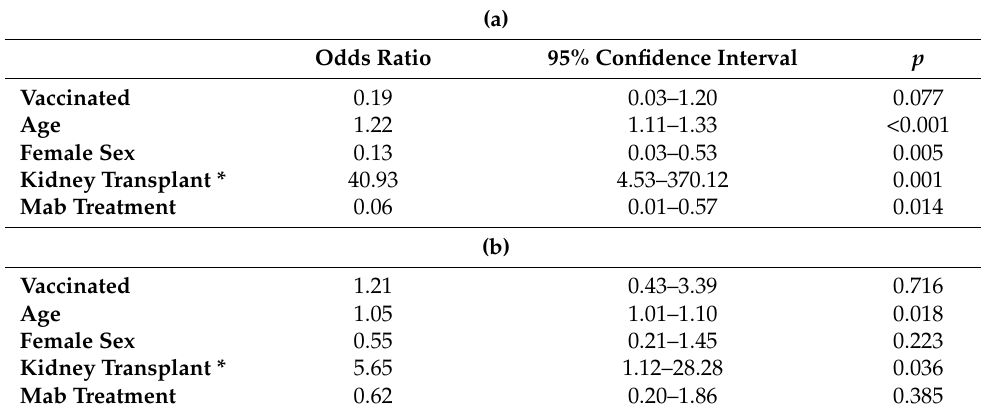
Table 2. Matched Data Reduced multivariable analysis for 60-day mortality and hospitalization. (a) Matched Data Reduced MVA for 60-Day Mortality (NT = 101) (b) Matched Data Reduced MVA for Hospitalization (NT =